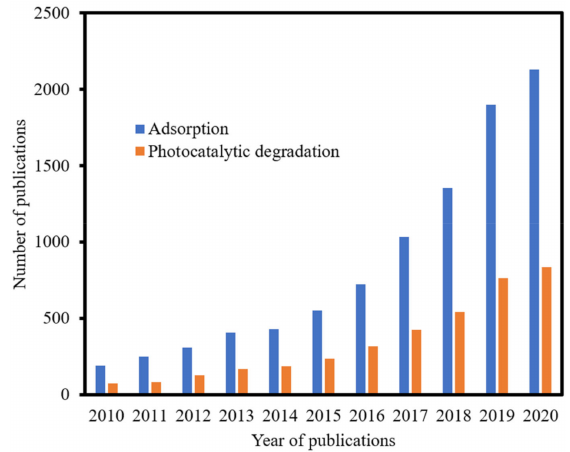
Figure 5. Publications from 2010–2020 on the adsorption and photocatalytic degradation of dyes using MOFs. Data was obtained from the science direct using keywords MOFs; adsorption, and photocatalytic degradations dyes.